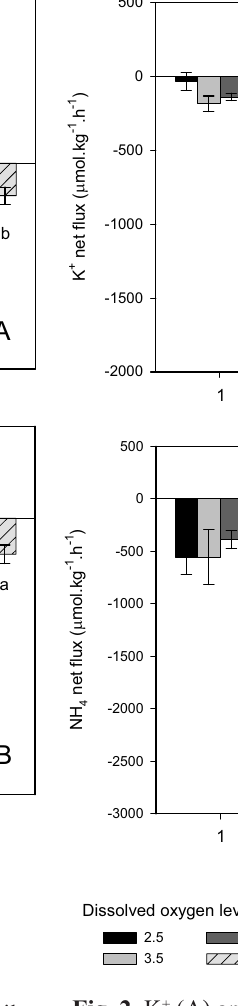
Fig. 1. Na + (A) and Cl - (B) net fluxes of silver catfish juveniles acclimated at 6.0 mg.L -1 dissolved oxygen levels and transferred to aquaria with different oxygen dissolved levels. Data expressed as mean ± SEM. Positive values indicate net influxes, and nega- tive values net effluxes. Different letters under the bars indicate significant difference among treatments at the same time after transference by two-way ANOVA and Tukey test (P < 0.05).